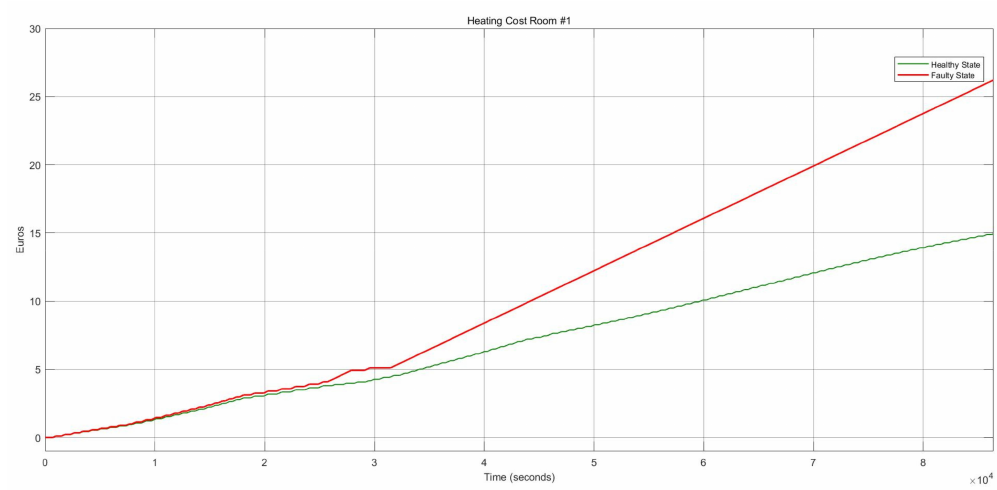
Figure 12. Heating cost conditions for the heater actuator and CO 2 sensor faults.